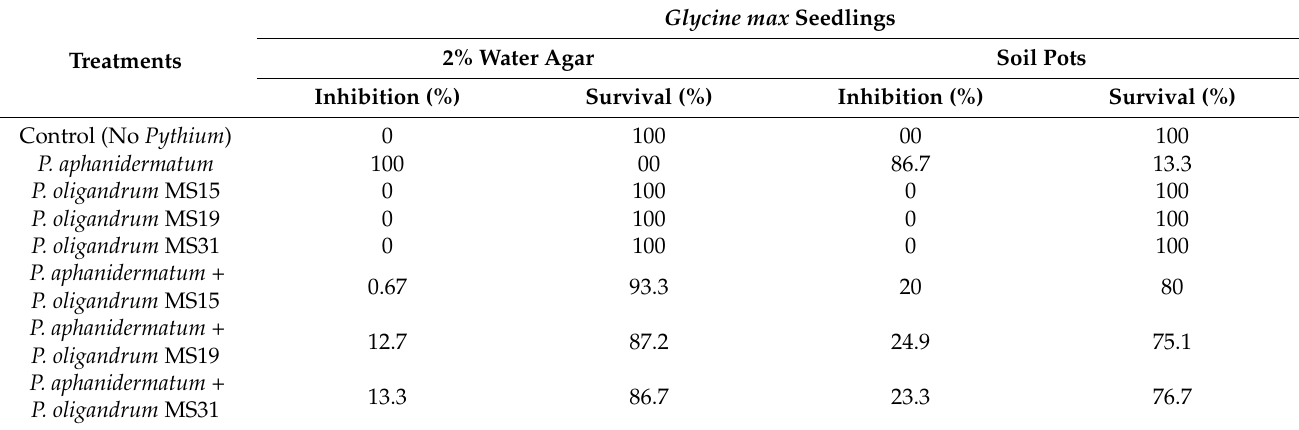
Figure 3. Hyphal interactions between P. oligandrum ( MS15 ) and P. aphanidermatum using SEM: ( 1 ) and ( 2 ) showing infection pegs of P. oligandrum; ( 3 ) and ( 4 ) showing torsion of P. oligandrum hyphae P. aphanidermatum and the arrow pointed to hyphal collapse and turgor loss of P. aphanidermatum hyphae. Table 4. Effect of P. oligandrum isolates on G. max pre-emergence damping-off disease grown in 2% water agar and in soil pots. Glycine max Seedlings 2% Water Agar Soil Pots Treatments Inhibition